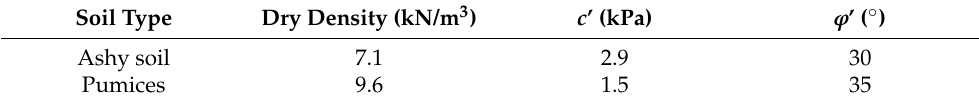
Table 4. Main physical and mechanical properties of the materials in Pizzo d’Alvano massif.